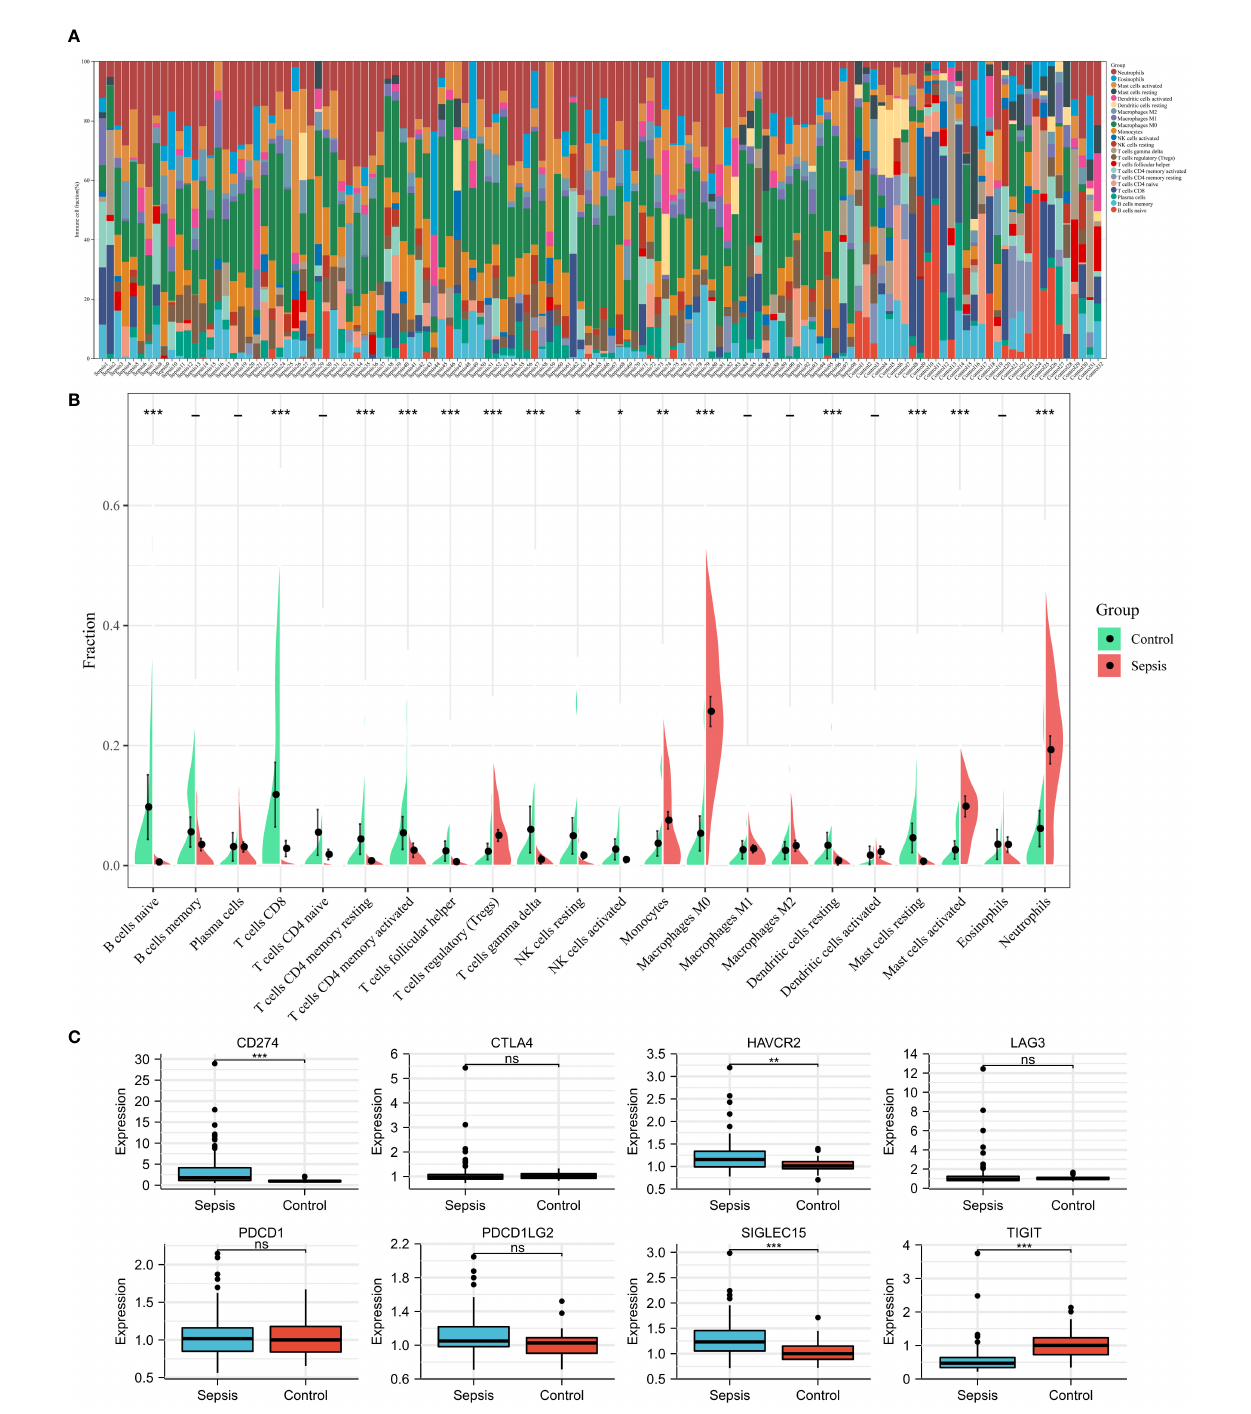
FIGURE 4 | Landscape of immune in fi ltration and immune checkpoint genes between sepsis and controls in children in the GSE26440 dataset. (A) Bar charts of 22 immune cell proportions in sepsis and controls. The fi rst 98 were sepsis, and the last 32 were controls. (B) Differential expression of different types of immune cell marker expression between sepsis and controls. (C) Differential expression of different immune checkpoint genes between sepsis and controls. *P < 0.05, **P < 0.01, ***P < 0.001, ns P >